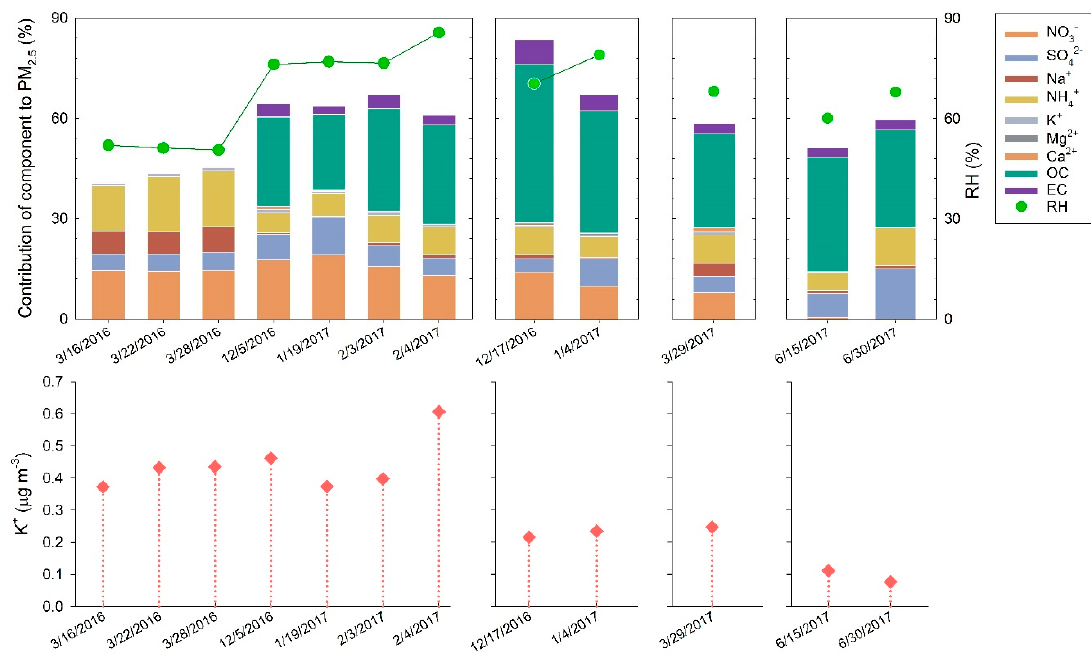
Figure 8. Characteristics of each type of HCE: ( a ) NO 3— –driven, ( b ) organic carbon (OC)–driven, ( c ) crustal element-driven, and ( d ) summer HCEs. The lower graphs show the K + concentration in each HCE sample.